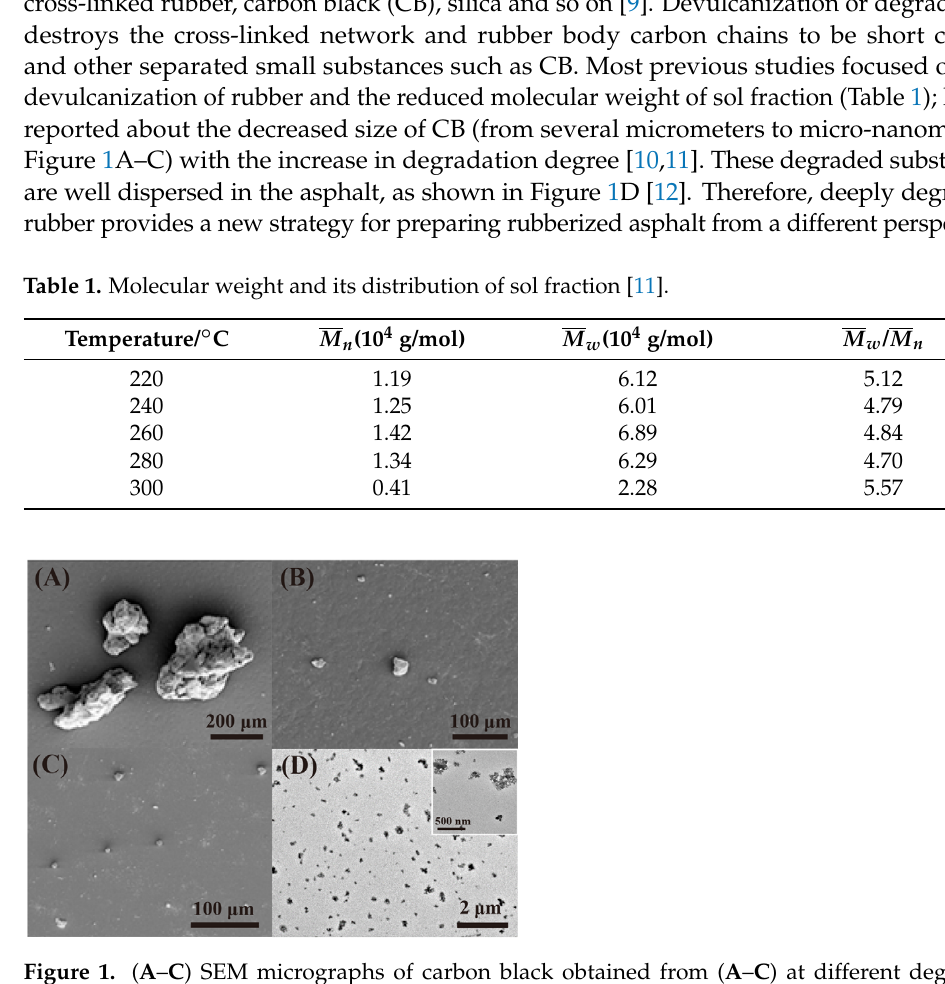
Table 1. Molecular weight and its distribution of sol fraction